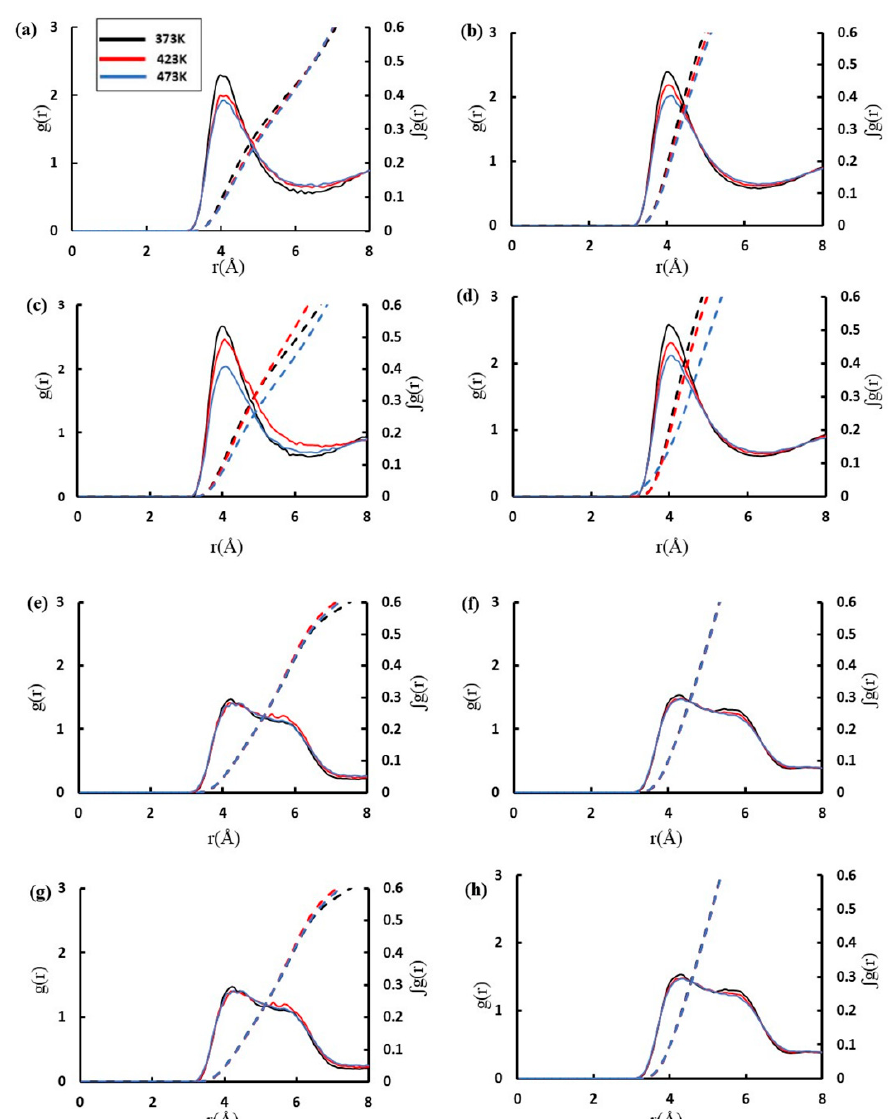
Figure 6. The radial distribution function for *C–*C showing the probability for methanol agglomeration as a function of temperature in H-Beta with loadings of ( a ) 2 and ( b ) 4 mpuc; in all-silica Beta with loadings of ( c ) 2 and ( d ) 4 mpuc; in H-MFI with loadings of ( e ) 3 and ( f ) 5 mpuc; and all-silica MFI with loadings of ( g ) 3 and ( h ) 5 mpuc.